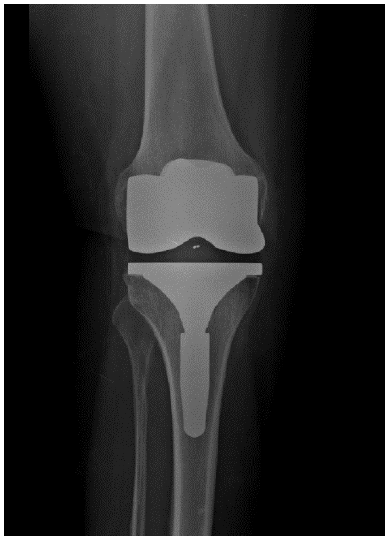
Figure 3. Anteroposterior radiograph of the Advanced Coated System (ACS) total knee prosthesis 12 months after surgery.